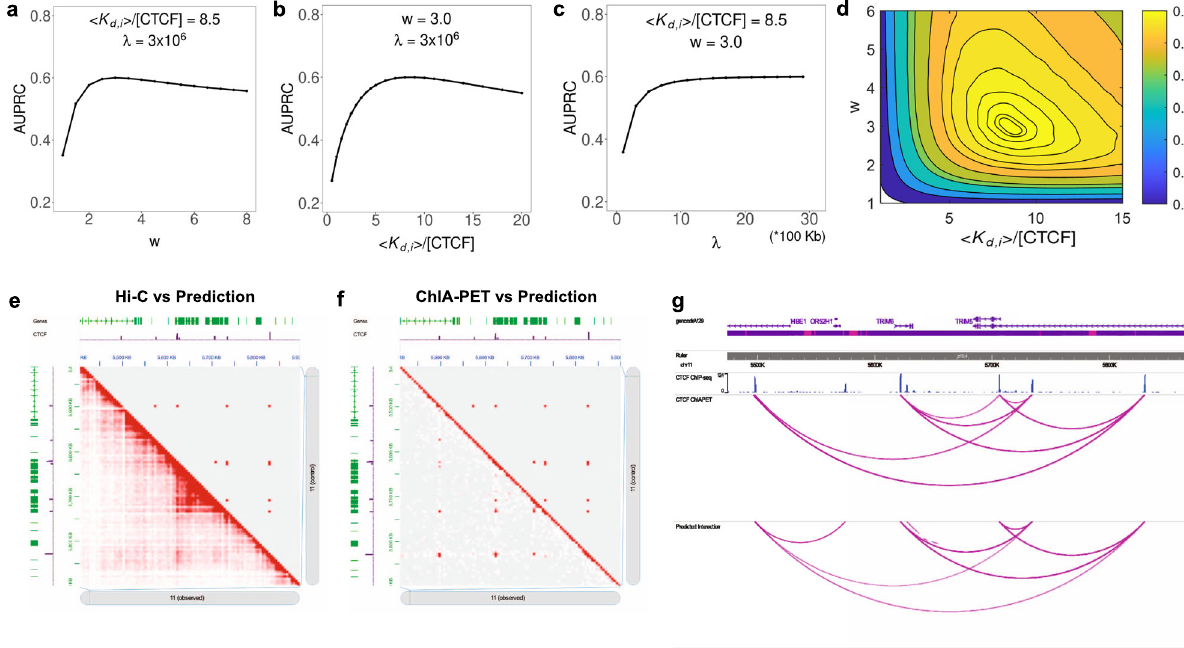
Fig. 2 Model predictions compare favorably with Hi-C and ChIA-PET data in the TRIM5/6 locus. a – d Model performance is evaluated by area under precision-recall curve (AUPRC) as parameters are varied individually ( a – c ), and by grid search ( d ). Model predictions (upper-right) compared to ( e ) Hi-C data (bottom left) and f ChIA-PET data (bottom left). CTCF ChIP-seq signal is also shown as purple tracks in ( e , f ). The model predicts most of the direct CTCF ChIA-PET loop interactions, and Hi-C picks up additional contacts within the loops (or TADs) that are not the result of direct CTCF – CTCF interactions. g In the same locus, loops called by our model and ChIA-PET data are quite similar, as visualized using the WashU epigenome